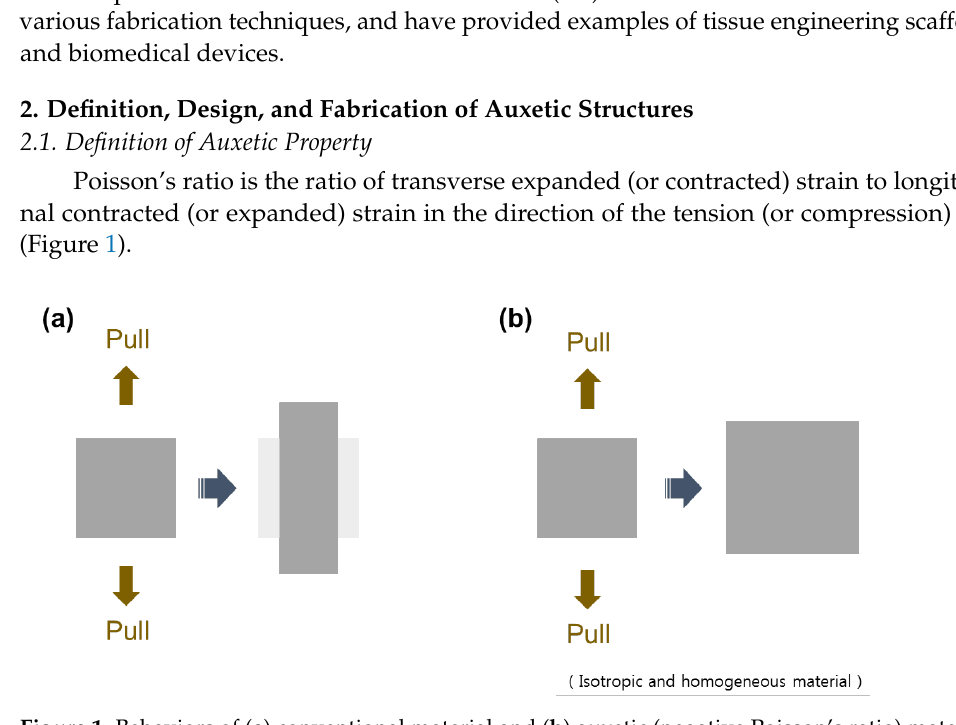
Figure 1. Behaviors of ( a ) conventional material and ( b ) auxetic (negative Poisson’s ratio) material. Poisson’s ratio is defined